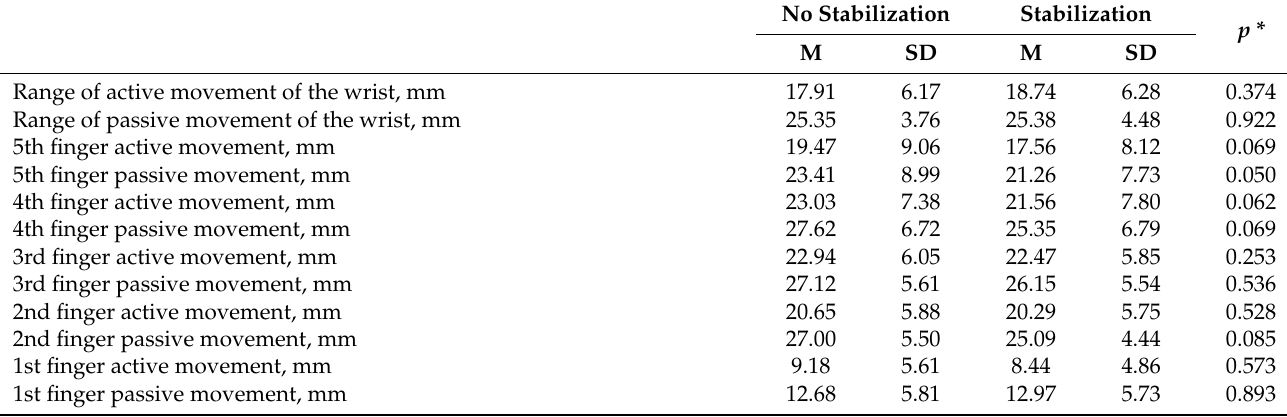
Table 2. Motor coordination of the hand and wrist in stroke patients with and without stabilization of the trunk and upper limb.